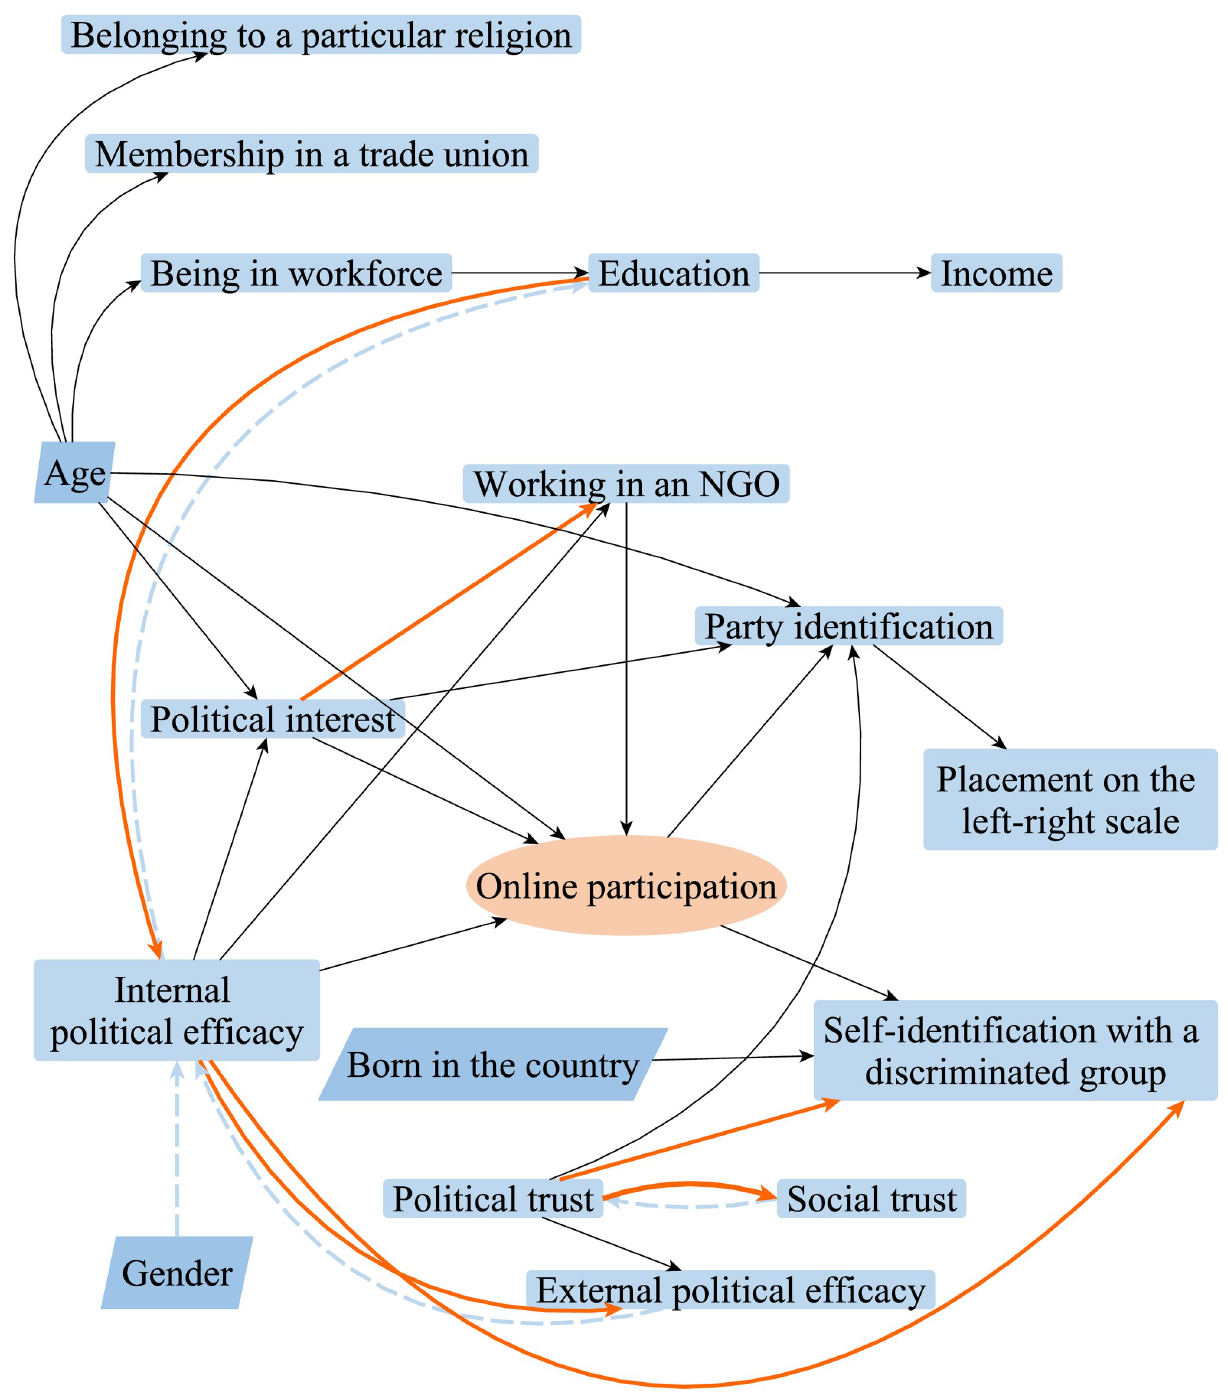
Fig 3. Directed acyclic graphs of the relations between factors associated with participation in online activism. Source : [35]. N = 27 379 individuals in 19 countries. Notes : Within Bayesian network analysis, score-based Tabu and hybrid H2PC algorithms were applied to analyse the data and learn the structure of the causal relations between the variables. Dashed blue lines represent false positives, i.e., edges that are not present in the structure learned by the Tabu algorithm but present in the structure learned by H2PC. Orange lines represent false negatives, i.e., edges that are present in the structure learned by the Tabu algorithm but absent in the structure learned by H2PC. The direction of each arc represents the orientation of the causality between two variables: e.g., in a relationship A ! B , A is a parent and B is its child. All the edges from the other nodes to “Age”, “Gender” and “Born in the country” were blacklisted prior to learning the structure. No other edges were blacklisted. In the figure, those nodes that can only be parents have a darker blue color. The node “Country” (i.e., the country of the respondent’s residency) is present in the structure but not depicted by the figure to facilitate the apprehension of the relations between the nodes of interest. All variables are individual-level